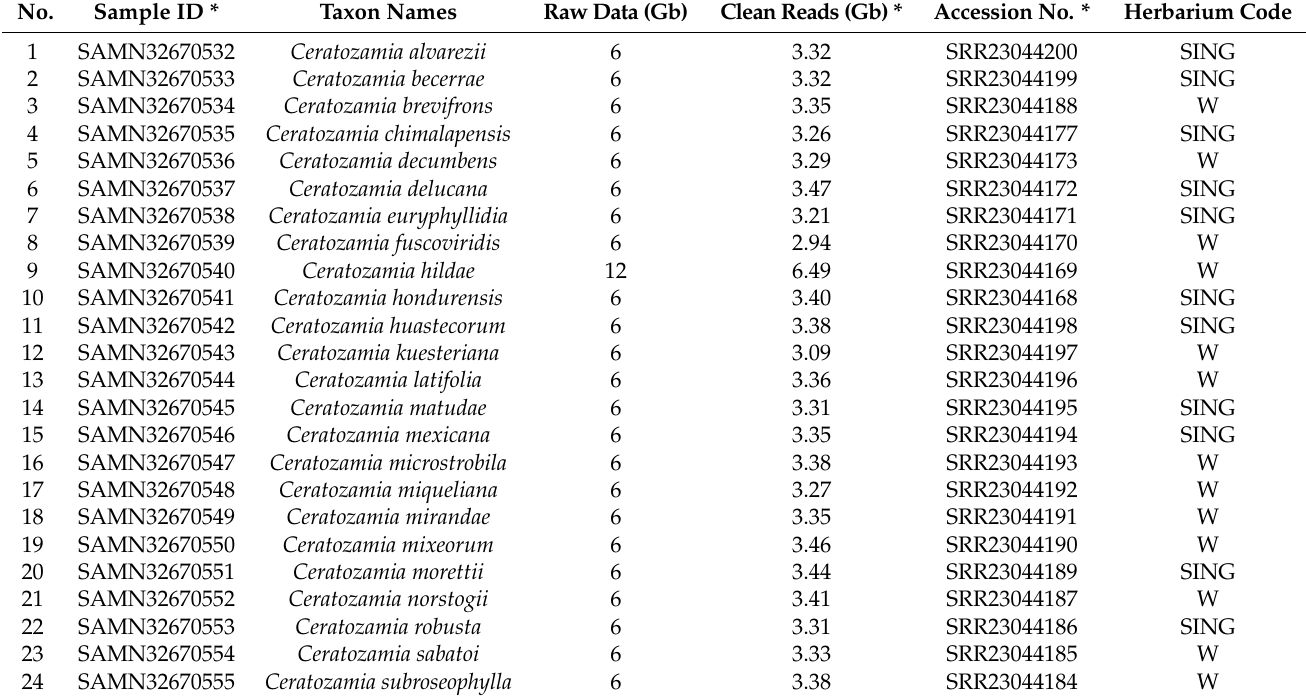
Table 1. List of Ceratozamia species and the three outgroup taxa included in this study for phylogenetic